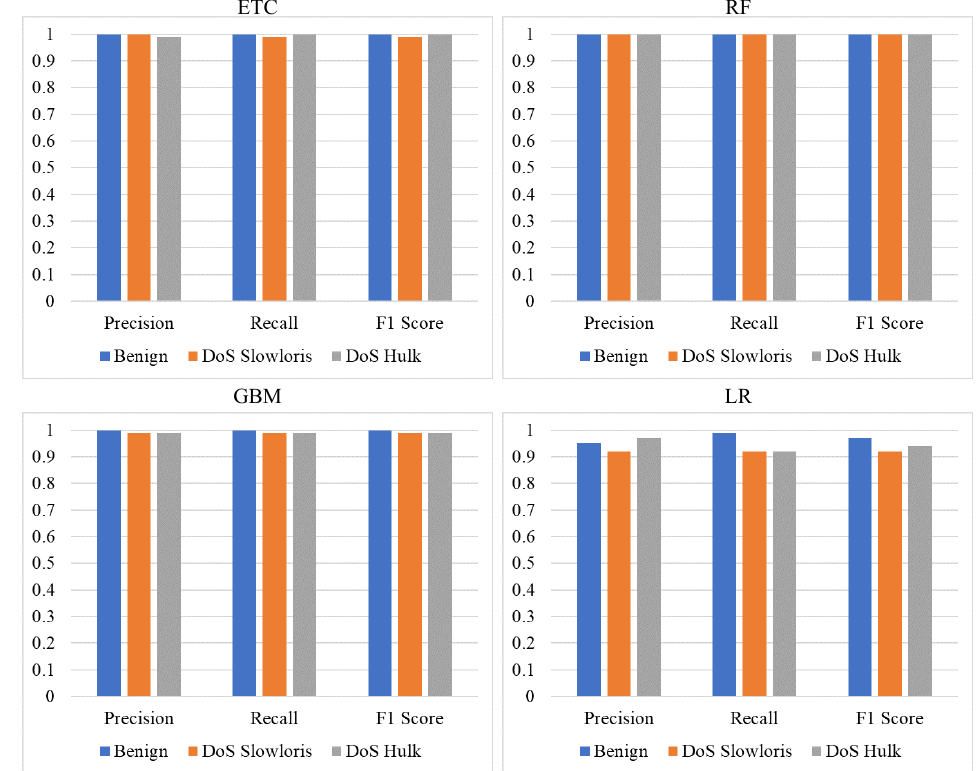
Figure 3. Performance comparison using all attributes.